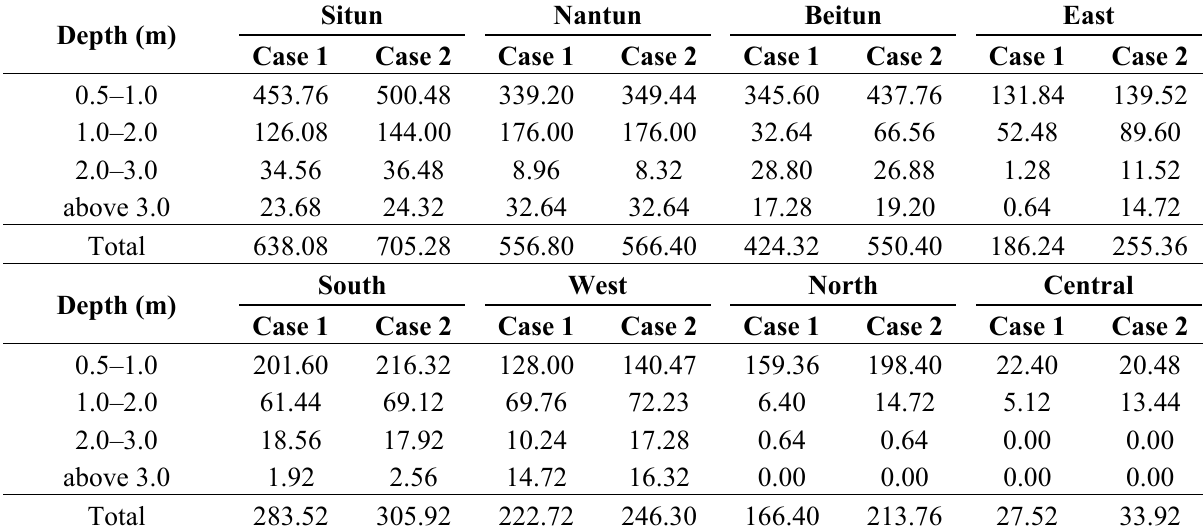
Table 7. Inundation area of each districts of Taichung City (unit: